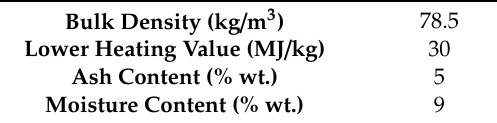
Table 6. Coal Quality Parameters.